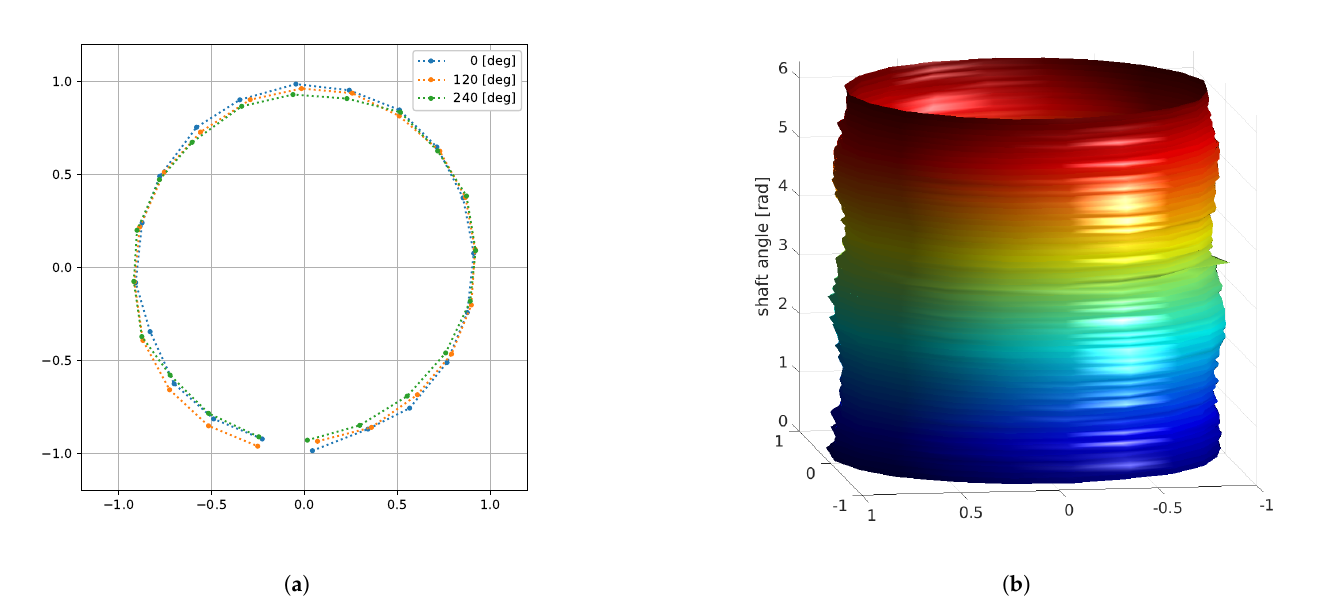
Figure 7. Experiment: the current hodograph for the examined machine. ( a ) Three frames every 120 degrees, normalized current. ( b ) 3D hodograph for data recorded in the laboratory. Full data record, some of which are shown in Figure